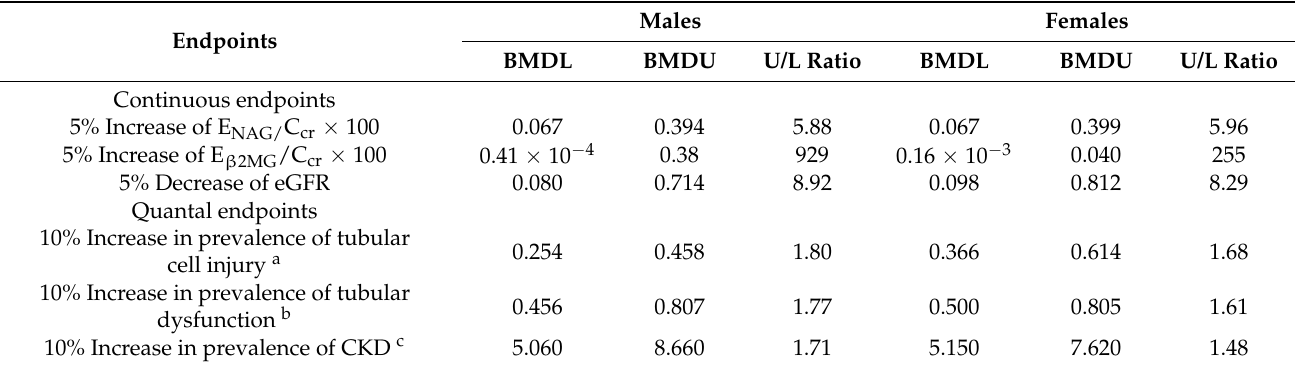
Table 4. BMDL and BMDU values of cadmium excretion levels associated with adverse effects on kidneys according to C cr -normalized